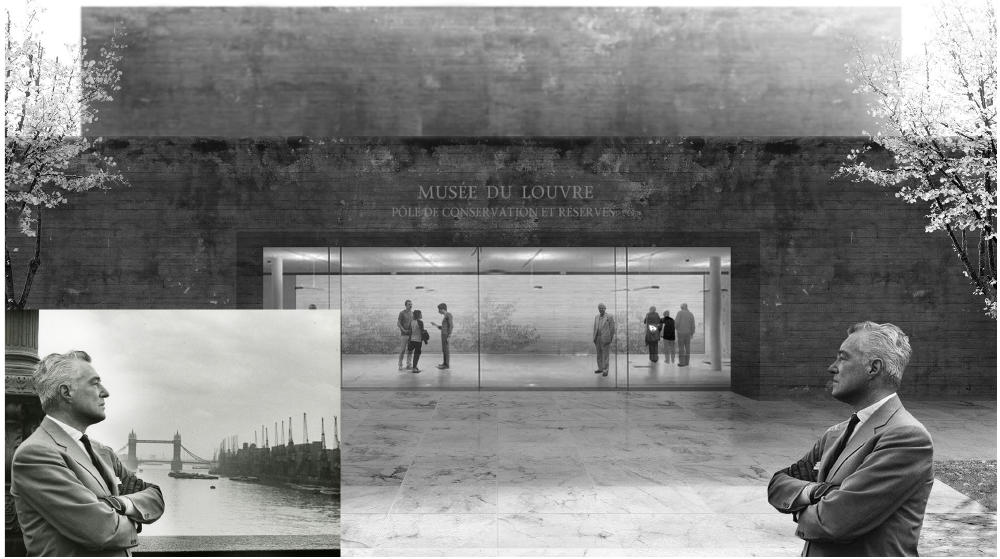
Fig. 4 Alberto Campo Baeza and Raphaël Gabrion, Conservation and Storage Facility for the Louvre Museum in Liévin , 2015. Digital rendering of the main entrance with Vittorio De Sica cut, mirrored, and pasted after a photograph of 1950s, here added at left (Courtesy of Campo Baeza and Raphaël